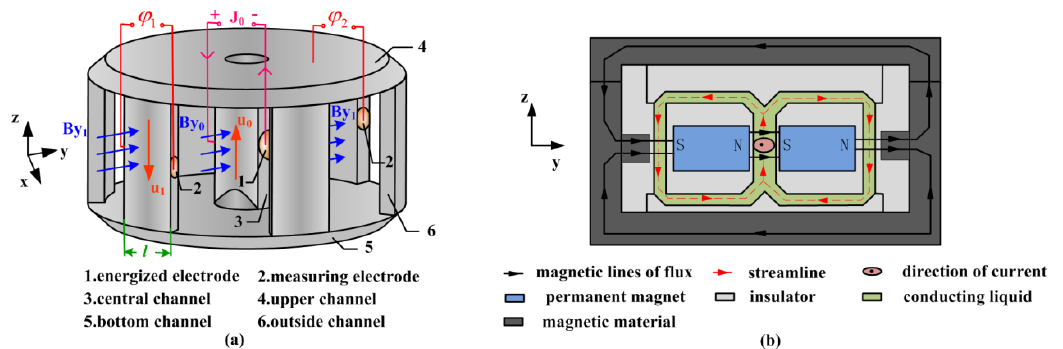
Figure 4. ( a ) Fluid channel of DRVG; ( b ) Sectional view of DRVG in yz